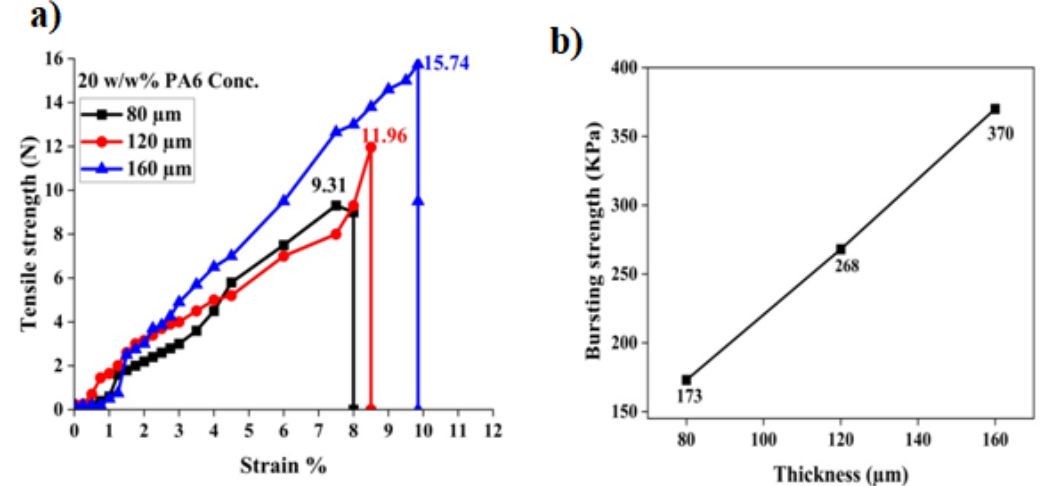
Figure 10. ( a ) Effect of nanofiber membrane thickness against the stress–strain curve. ( b ) Bursting strength of nanomembrane.